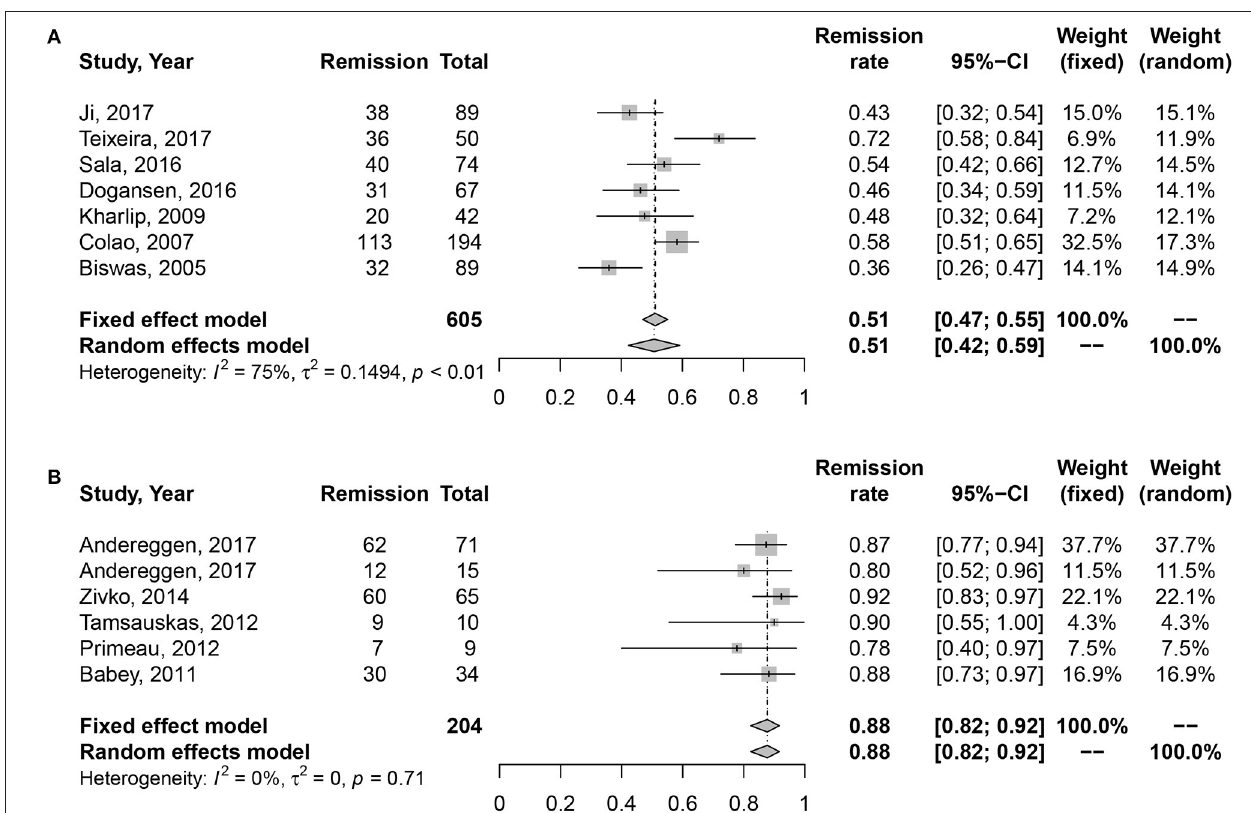
FIGURE 2 | Forest plots describing effects of medication vs. surgery as first-line treatment on the long-term remission rate of all prolactinomas. (A) Long-term remission rate in medication cohort for all prolactinomas. (B) Long-term remission rate in surgery cohort for all prolactinomas.